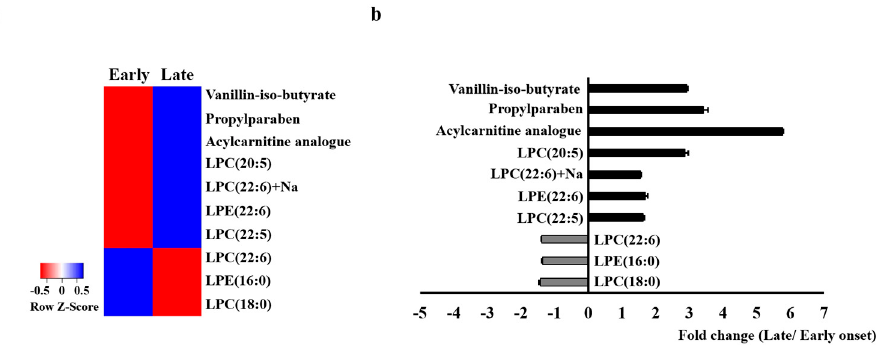
Figure 3. Heatmap of the identified serum metabolites ( a ) and the fold changes ( b ) between the early-onset group and the late-onset group. The color of each section corresponds to the concentration value for each metabolite calculated by the peak area normalization method (red, upregulated; blue, downregulated).